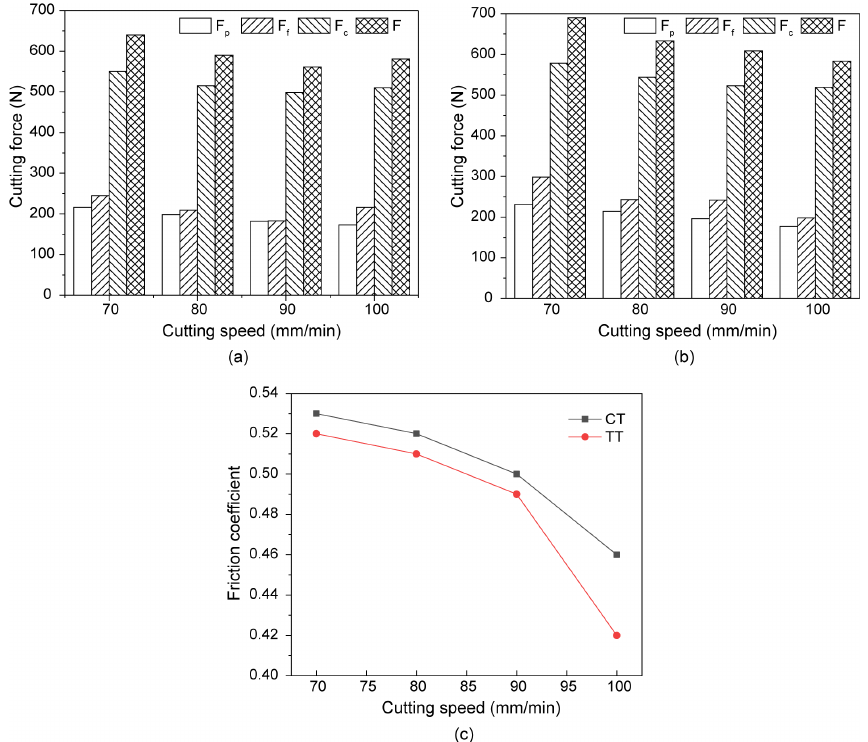
Figure 2. Effect of cutting speed of CTs (conventional tools) and TTs (micro-textured tools) on cutting force and average friction coefficient: (a) CT cutter cutting force with cutting speed, (b) TT cutter cutting force with cutting speed and (c) cutter-chip interface friction coefficient with cutting